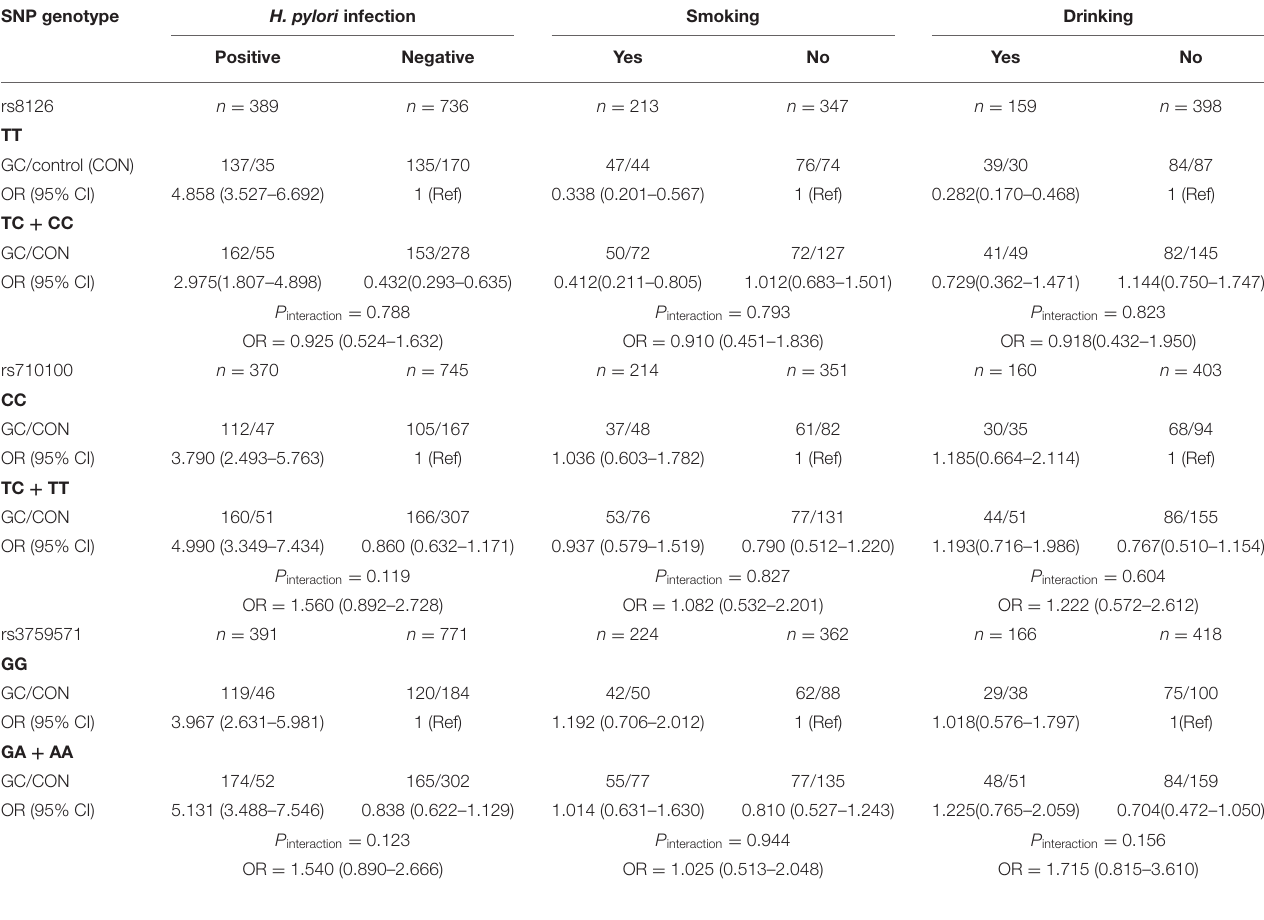
TABLE 4 | The interaction effects between TNFAIP2 TagSNPs and environmental factors on gastric cancer (GC)